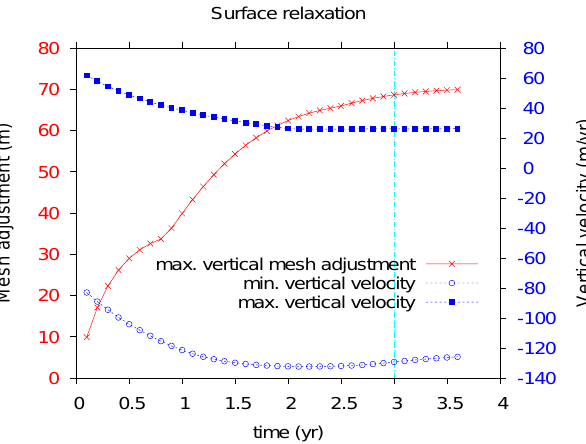
Figure 4. Evolution of maximum (and minimum) values of cumu- lated mesh adjustments and vertical velocities during the surface relaxation surfrelax95 to determine the end of the